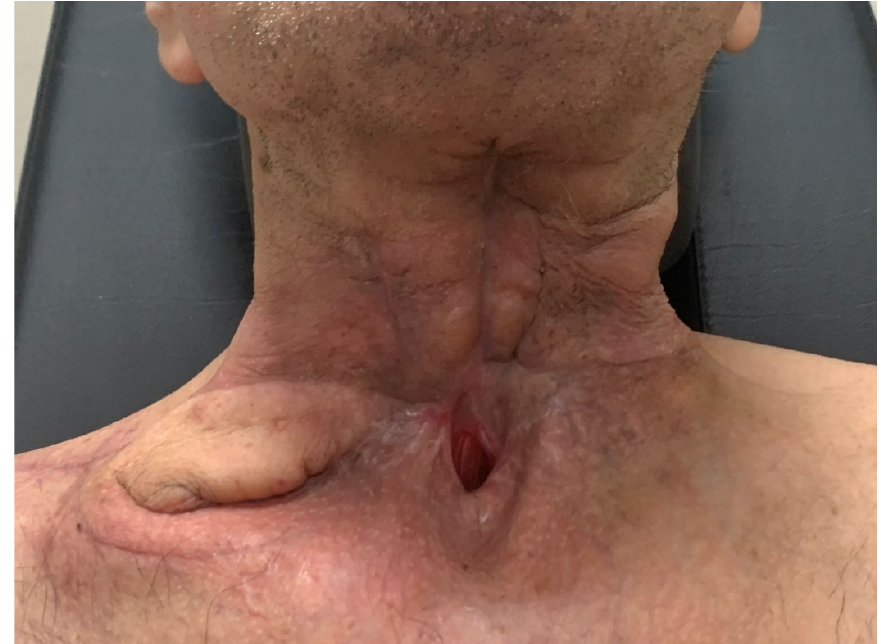
Figure 2. Aesthetic result at the 1-year follow-up .